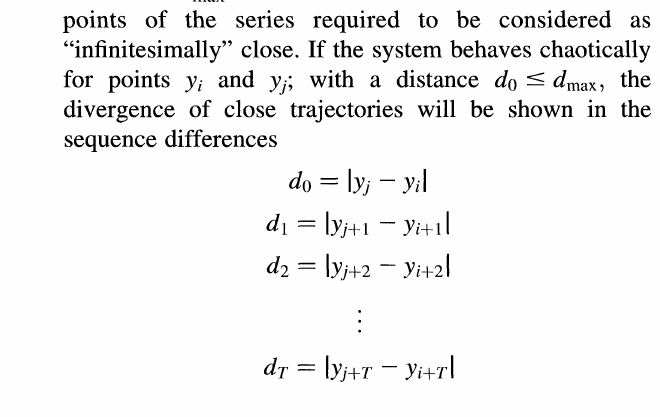
FIGURE Scale region for a series of distances obtained from yt+l 4yt(1